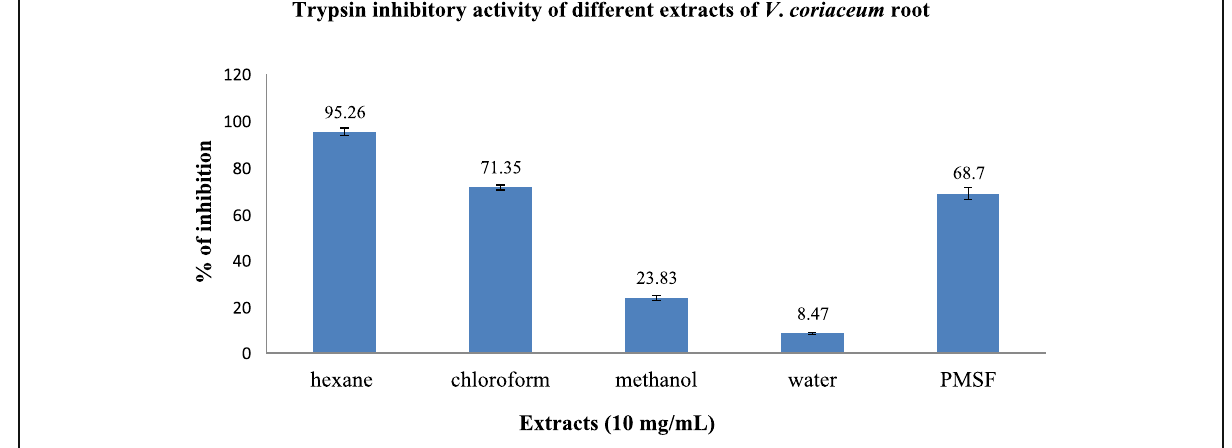
Fig. 5 Trypsin inhibition showed by different extracts of V .